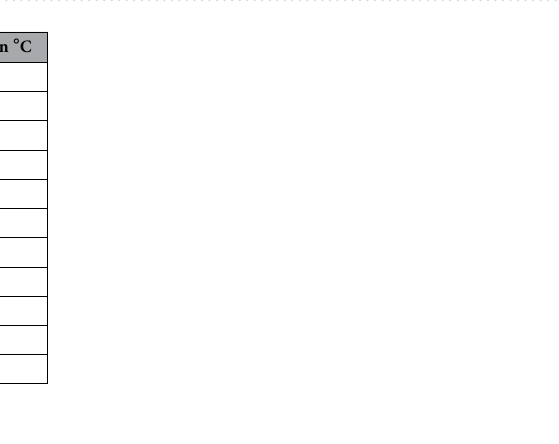
Figure 2. shows the model fit with a 95% confidence interval and the residuals.